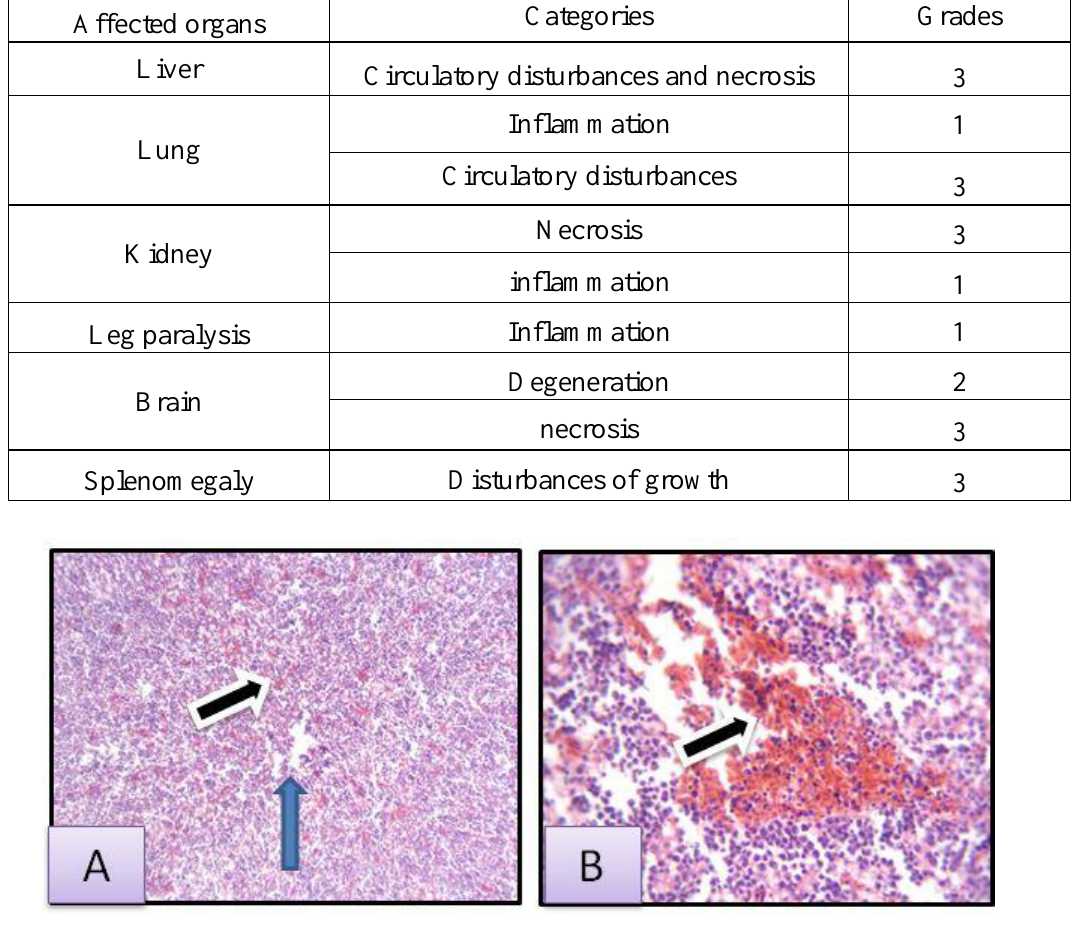
Fig. 6: liver section A : black arrow showed congestion while blue arrow showed degeneration and destruction of hepatic tissue, also there is loss of hepatic cord X (10). B: showed sever hemorrhage of hepatic tissue black arrow X( 100